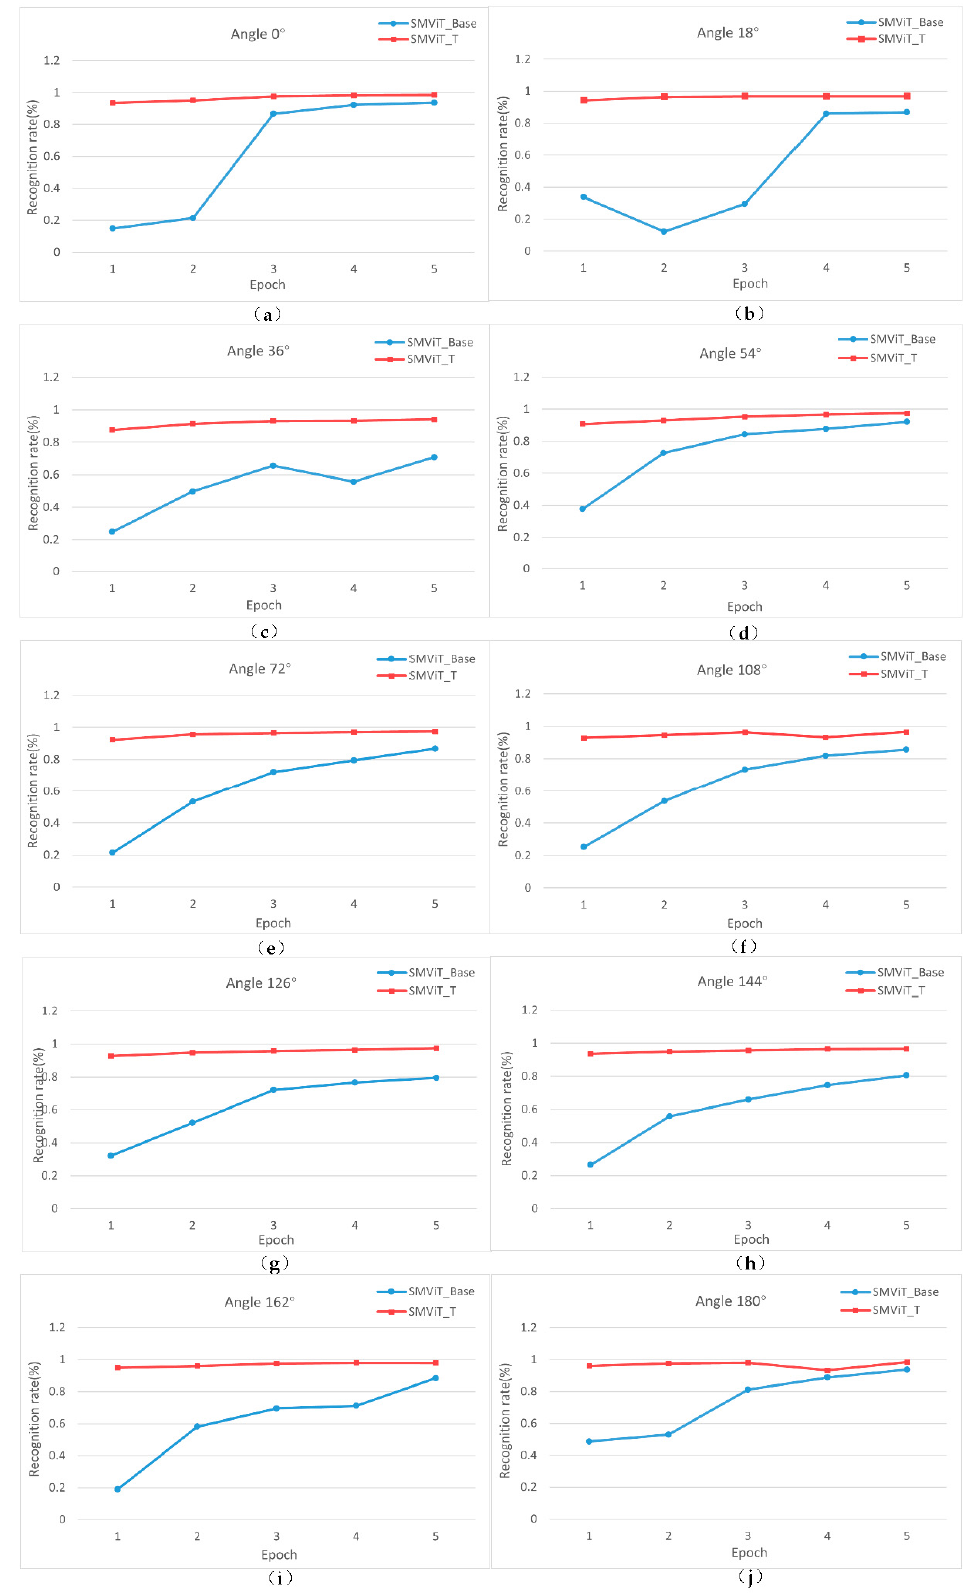
Figure 7. Diagram of the training process for the model proposed in this paper for various views in the CASIA B dataset (In the figure ( a – j ) are the experimental results of SMViT base and T in each